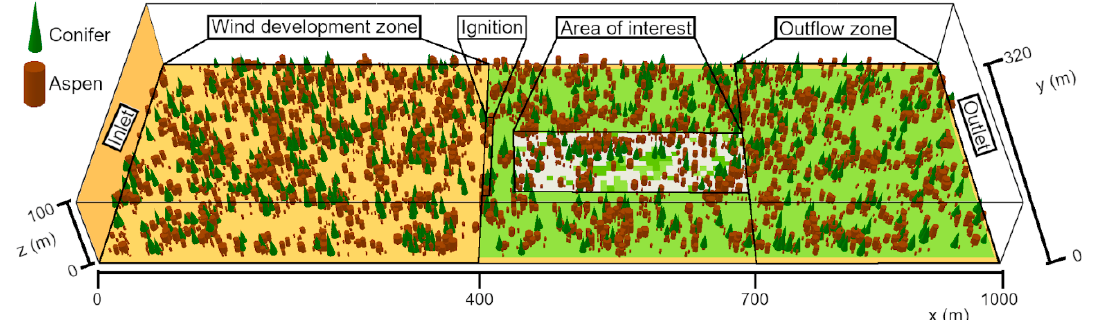
Figure 1. Example Wildland urban-interface Fire Dynamics Simulator domain used in this study, highlighting regions within the domain.